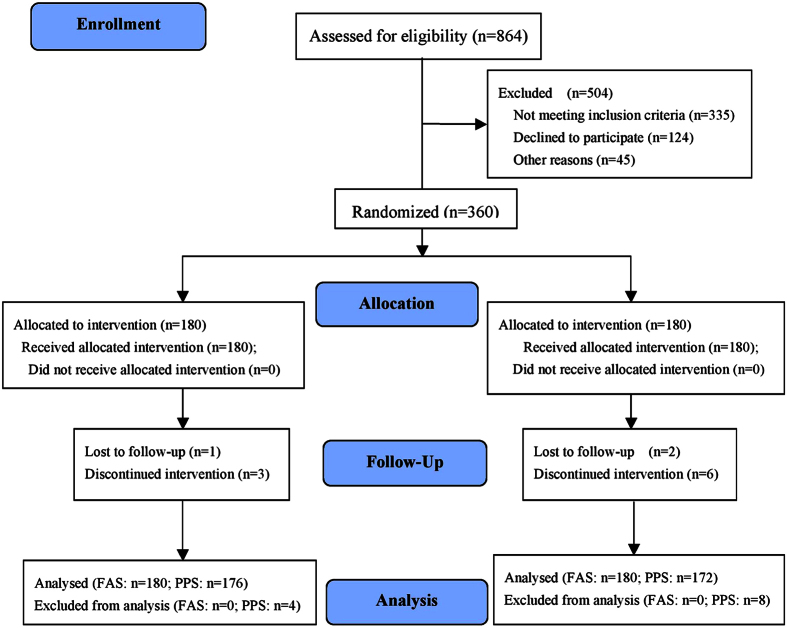
Flow of participants through the trial.